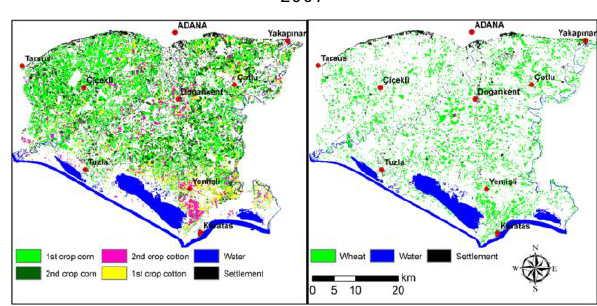
Figure 2. Classified wheat, Corn and Cotton crop pattern in 2007